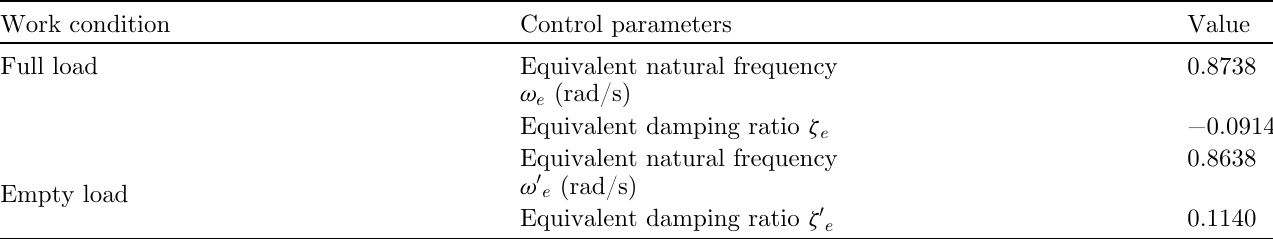
Table 2. Optimal control